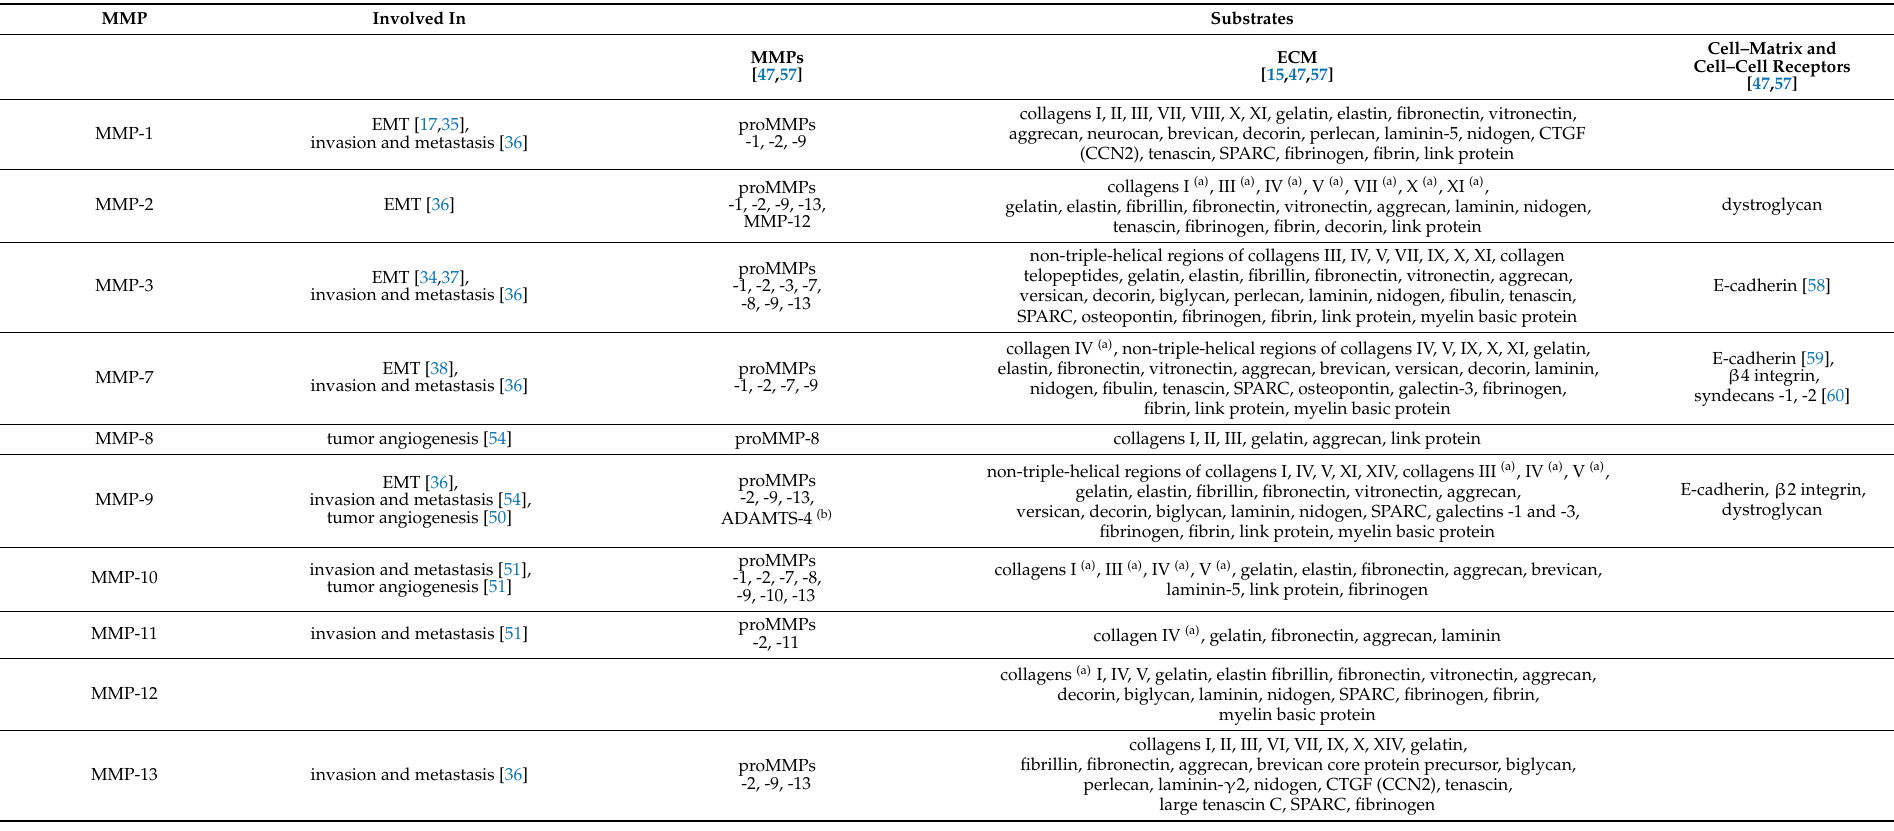
Table 1. Contribution of MMPs to cancer progression and their main proteolytic activities. Individual MMPs are involved to varying degrees in different stages of cancer progression by activating other MMPs and cleaving ECM components as well as other pericellular molecules. Further MMP substrates that are not directly related to cell–matrix and cell–cell interaction can be found in the